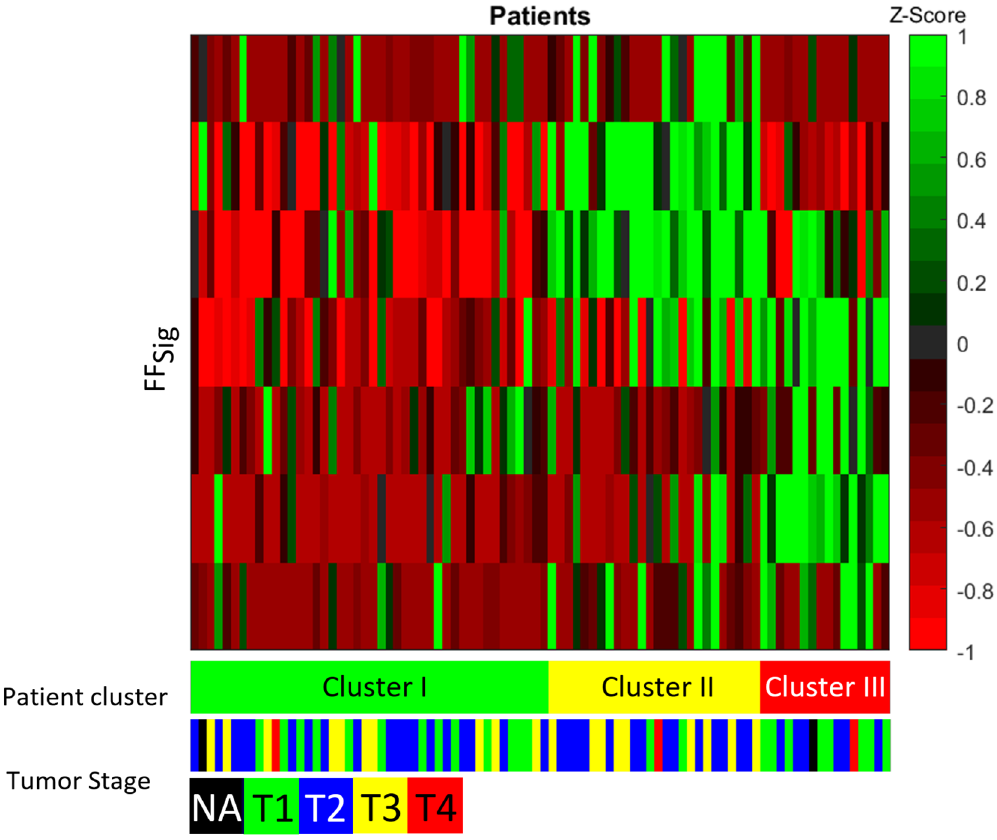
Figure 2. Heatmap of the FF Sig across patient clusters with corresponding T stage from the NRG-H dataset. The heatmap was generated using MATLAB, version 2019b, URL: https:// www. mathw orks. com/ produ cts/ matlab. html.